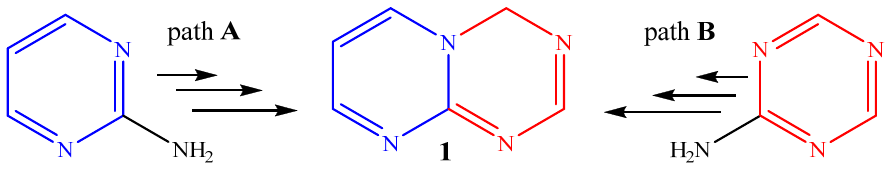
Figure 2. The structure of pyrimido[1,2-a][1,3,5]triazines and the main routes of their synthesis.